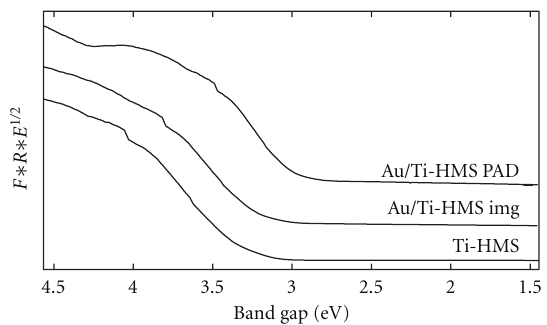
Figure 4: Fourier transforms of the Pt LIII-edge EXAFS spectra for